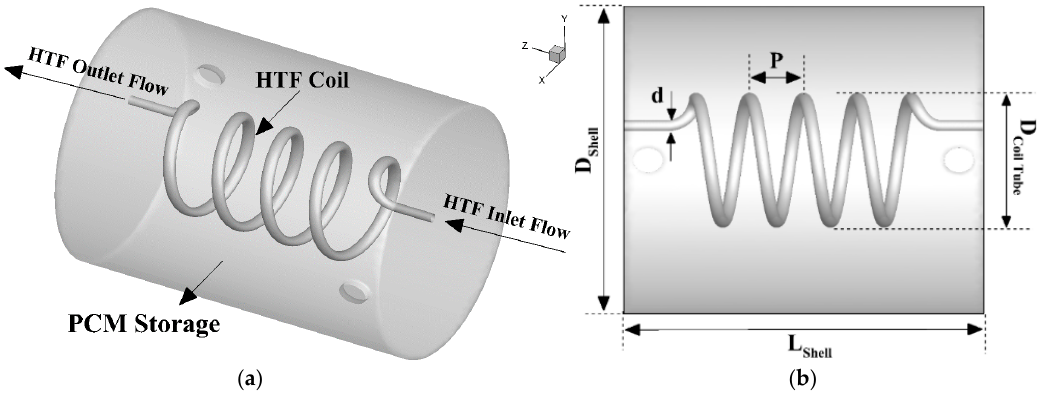
Figure 1. Schematic of the shell and coil tube PCM storage with relevant geometrical parameters.